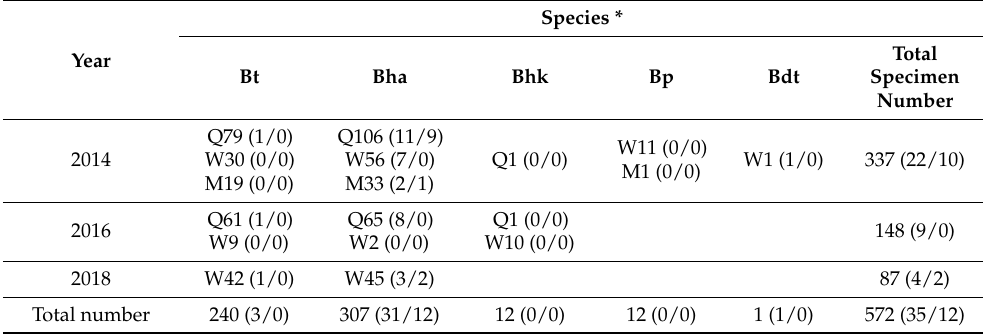
Table 1. List of bumblebee species collected in Biei and Kamifurano, Hokkaido and results of the PCR amplification of small subunit (SSU) rRNA and